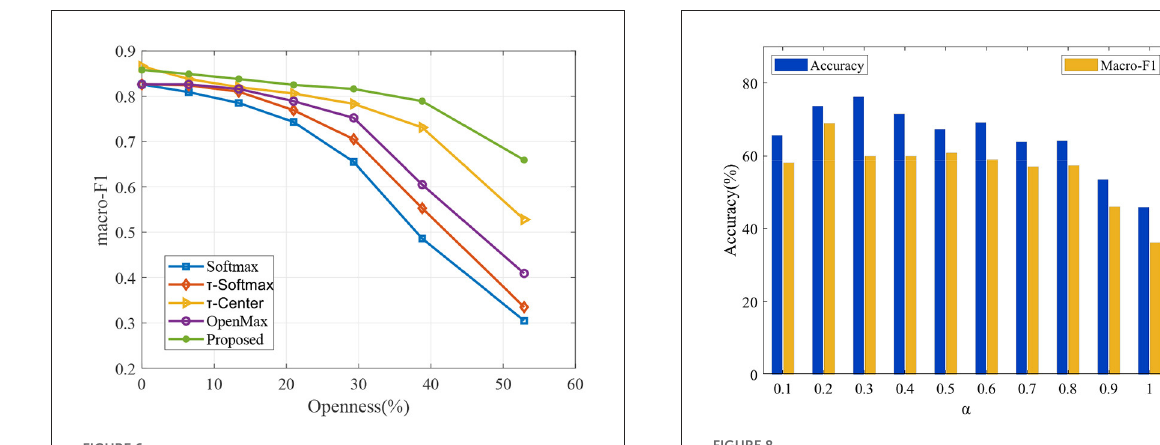
FIGURE6 Macro F1 against varying openness with different methods on the PHAC-2 dataset.